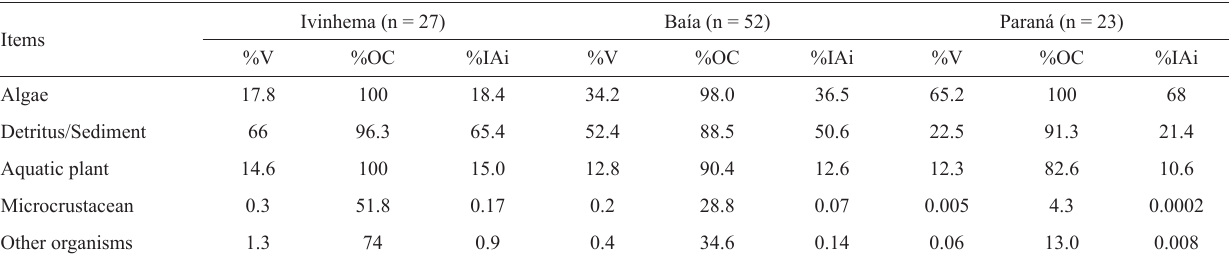
Table 3. Diet of Hemiodus orthonops in the different subsystems of the upper Paraná River floodplain. V = volume; OC = occurrence; IAi% = food